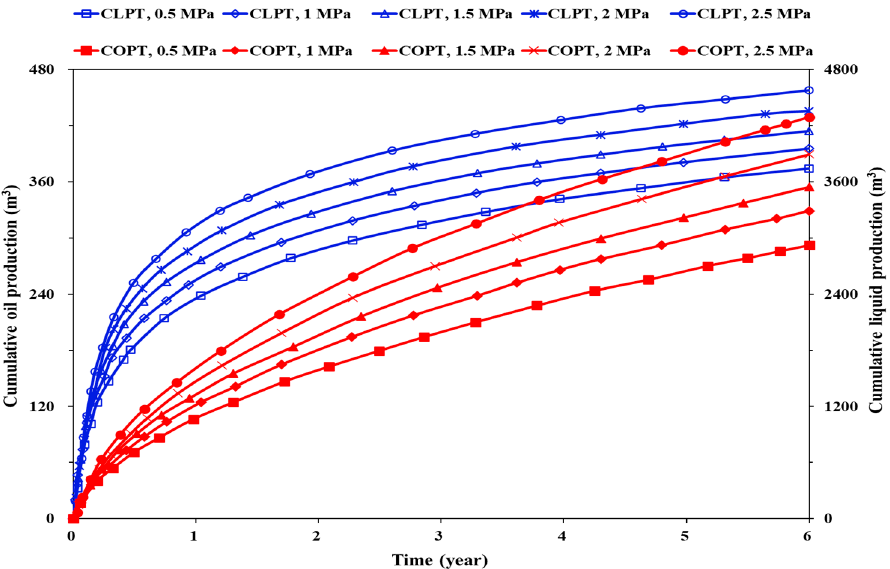
Figure 20. Production performance curves with varying stress difference (6 years of production).